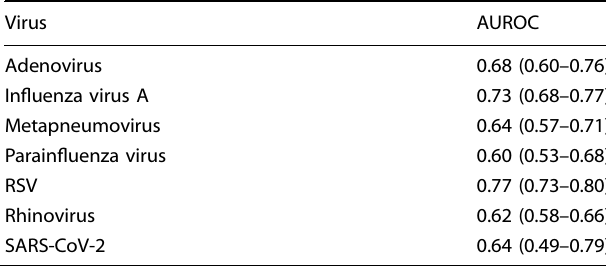
Table 1. AUROCs of logistic regression models for each respiratory virus with 95% con fi dence intervals .